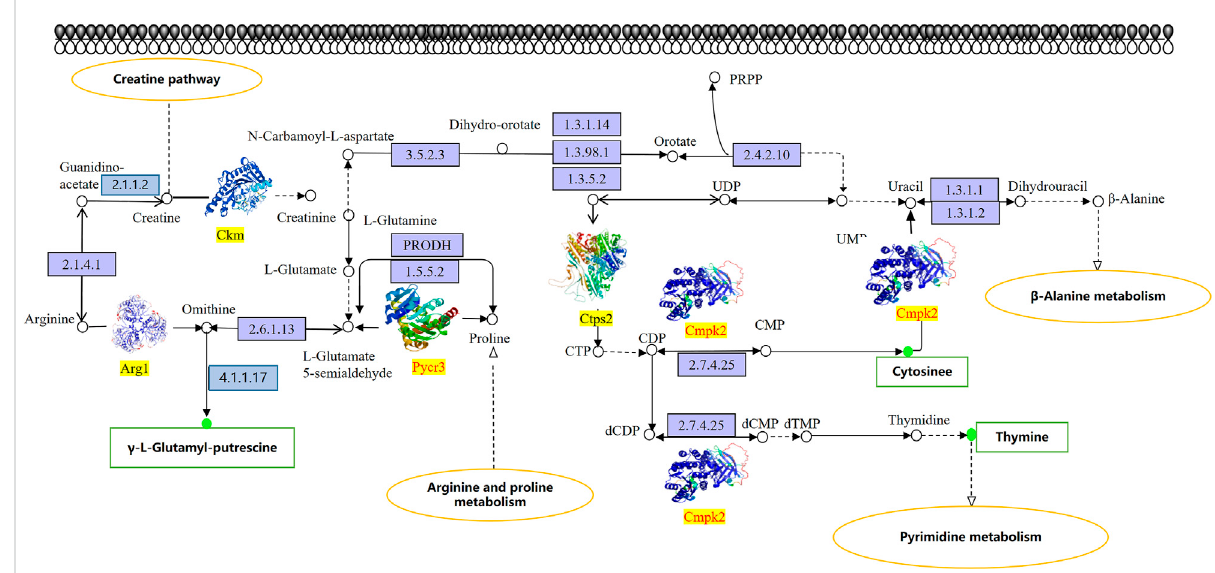
FIGURE 6 KEGG pathway map of differential metabolites and protein. The box in the fi gure represents the gene product and the circle represents the metabolite. All gene products in the blue background box re fl ect background proteins, Ckm, Arg1, and Ctps2 are up-regulated proteins, Pycr3 and Cmpk2 aredown-regulatedproteins.Themetabolitesseeninthered/green circlesare detecteddifferentialmetabolites,theredcircles indicateup- regulated metabolites, and the green circles indicate down-regulated metabolites.